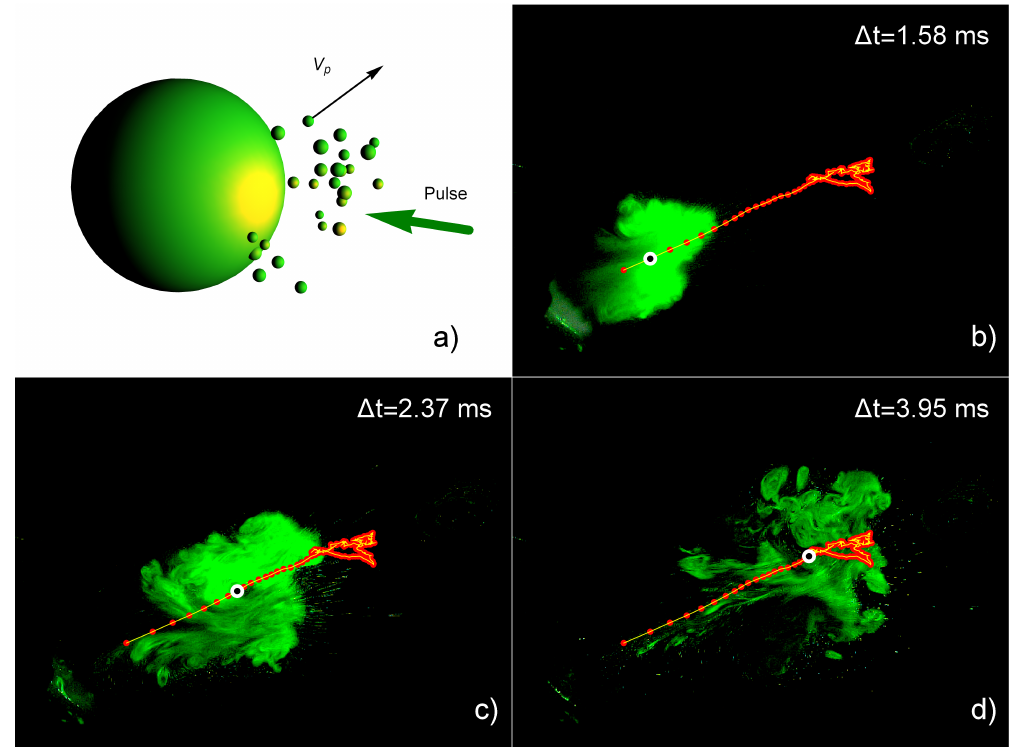
Figure 2. An interaction of the light pulse with an initial fuel droplet ( a ). The sequence of video frames showing the propagation of the gas-aerosol cloud ( b – d ). The green diffuse spot is a gas cloud, small green spots are ejected particles. The trajectory of the center of mass of cloud is shown by yellow line with red points (its position at moment ∆ t is marked by the white